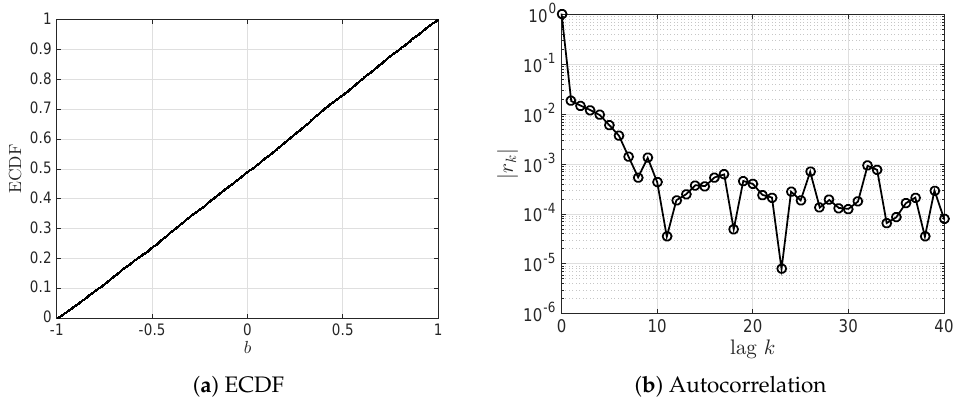
Figure 2. Empirical cumulative distribution function and absolute autocorrelation coefficient of a sampled chaotic sequence { b i } using Tent mapping equation, where functions cdfplot() and xcorr() in MATLAB are used to calculate ECDF and r k , respectively.